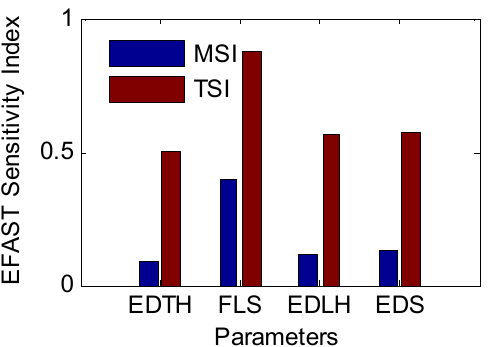
Figure 11. Main sensitivity index and total sensitivity index of different atmospheric duct parameters on GNSS signal propagation.